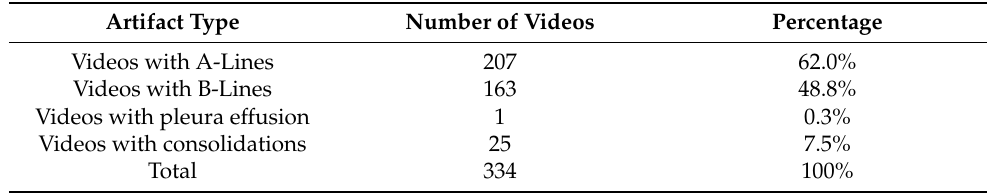
Table 3. Dataset statistics from the expert